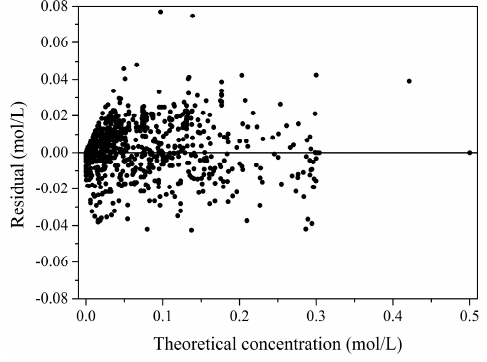
Figure 5. Residual plot of theoretical concentrations.